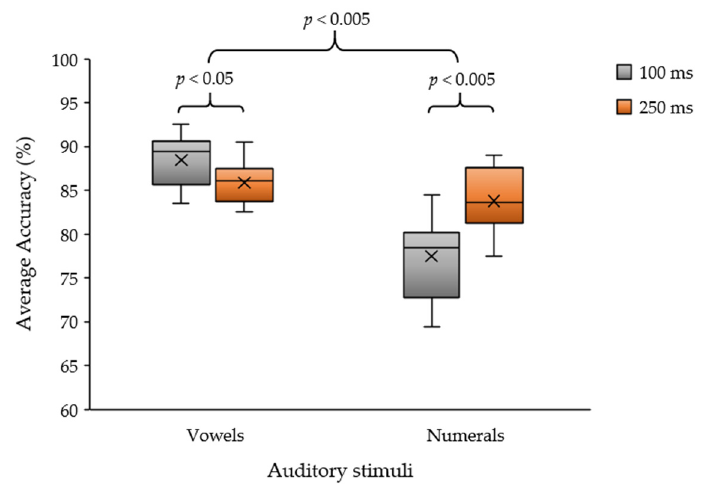
Figure 8. Average classification accuracy between vowels and numeral sounds in auditory stimulus intervals of 100 ms and 250 ms.